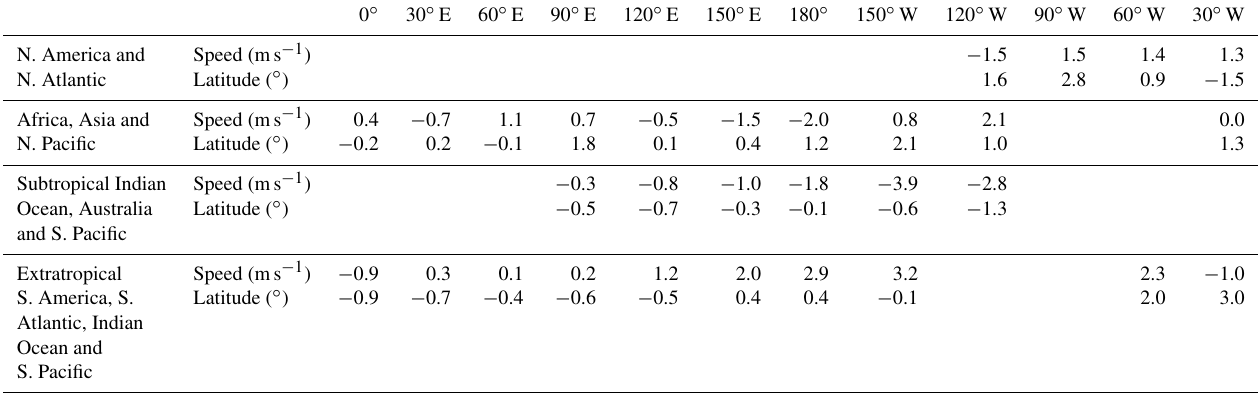
Table 3. Nominal changes in 200hPa wind speed maxima from March 1979 to February 2022 for selected longitudes and four jet-stream regions, based on the fields shown in Fig. 10a and b. Corresponding changes in the latitudes of the wind maxima are also shown. 0 ◦ 30 ◦ E 60 ◦ E 90 ◦ E 120 ◦ E 150 ◦ E 180 ◦ 150 ◦